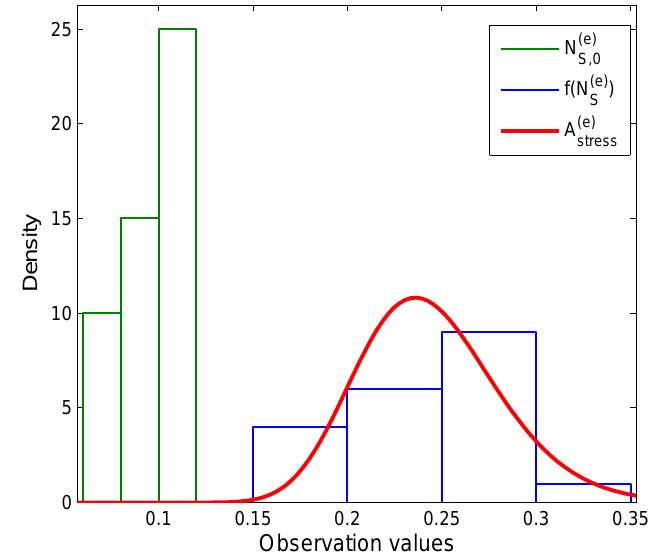
Figure 6. Number of overlaps identified vs. observation values for area stress.